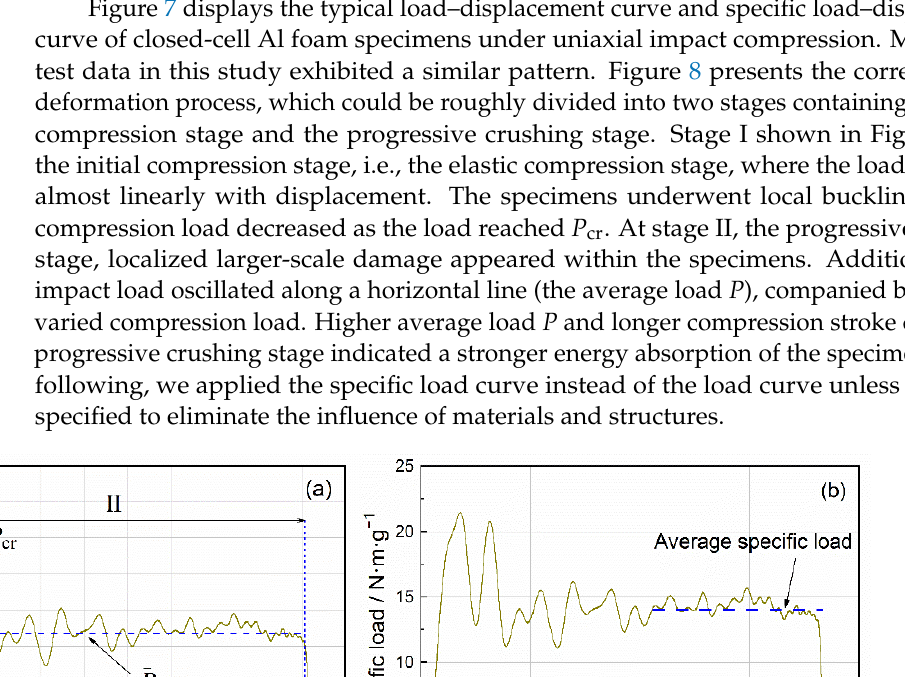
Figure 6. Velocity and displacement duration of Al foam with different porosities ( a ) velocity duration ( b ) displacement duration.